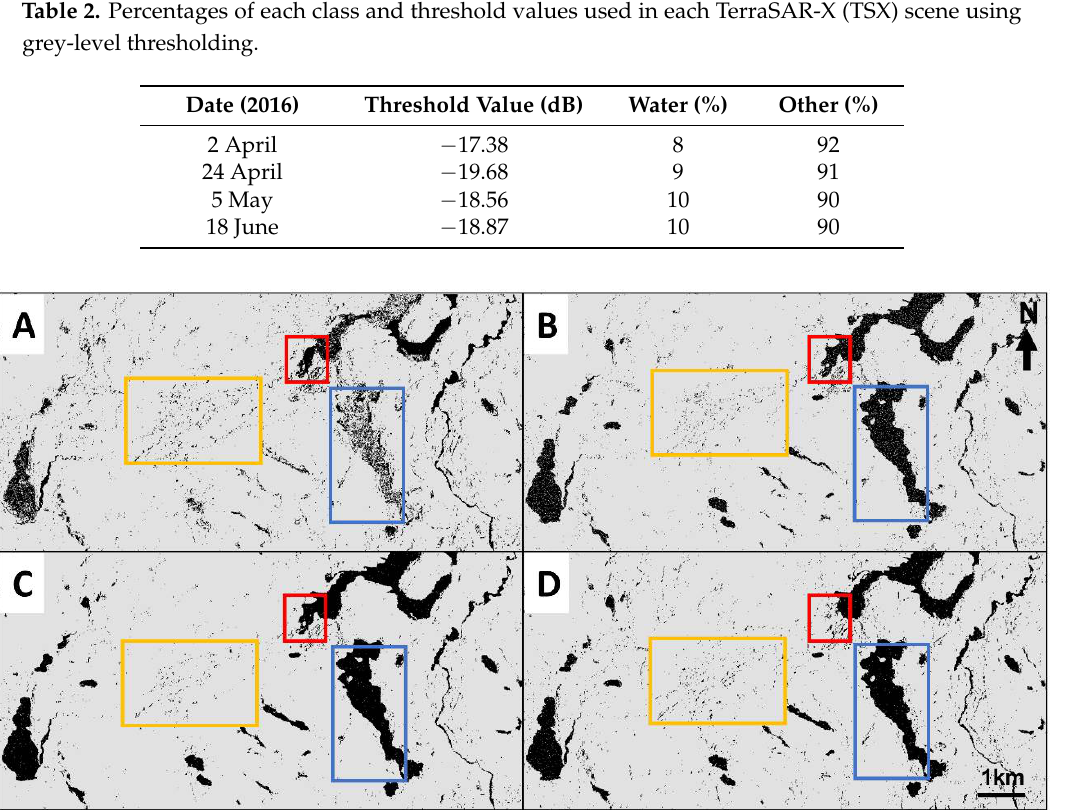
Figure 6. Grey-level thresholding classified models showing water (black) and other (grey) for ( A ) 2 April 2016; ( B ) 24 April 2016; ( C ) 5 May 2016; and ( D ) 18 June 2016. Coloured boxes indicate example areas of temporal change: blue—ice melting; red—marshland dries out; yellow—areas of misclassification due to ice ( A ) and vegetation ( C ).